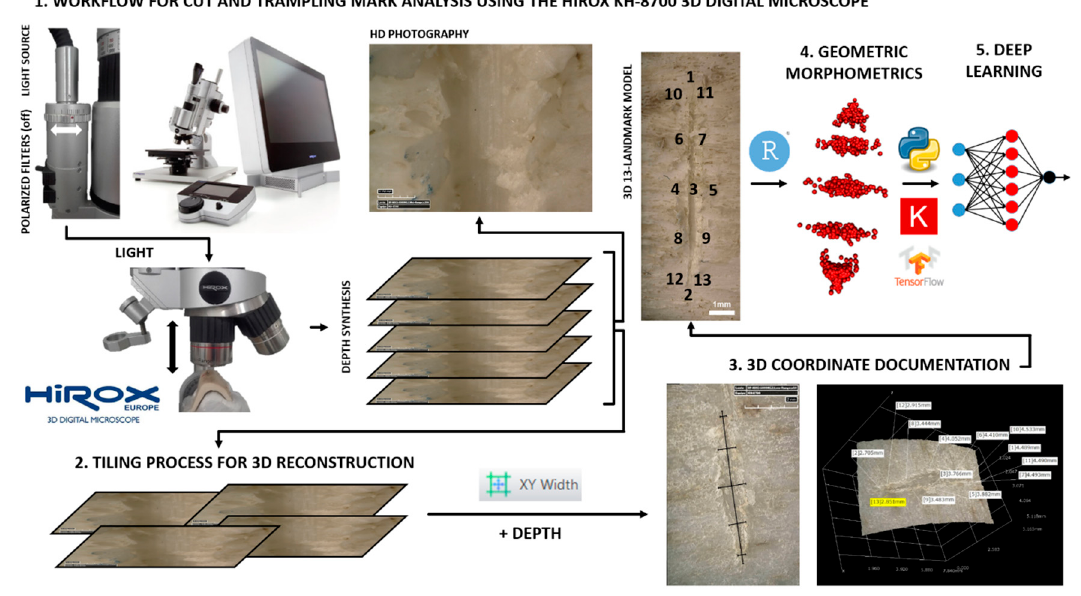
Figure 2. Graphical description of the proposed methodological workflow using the HIROX KH-8700 3D Digital Microscope, as described in detail through Courtenay et al. [21,37]. Figure by L.A.C.